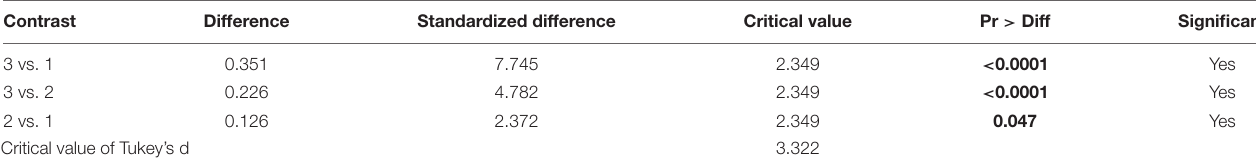
FIGURE 5 | Inferential analysis through ANOVA. TABLE 8 | Class_heritage/Tukey (HSD)/analysis of the differences between the categories with a confidence interval of 95%